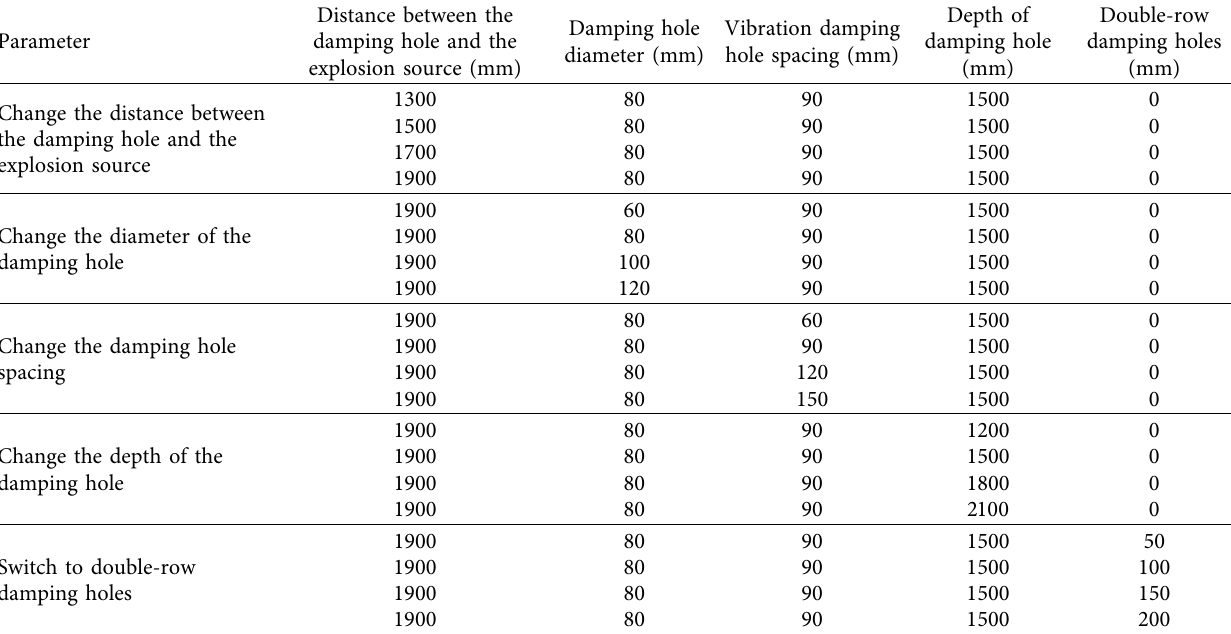
Table 3: Model size of damping hole.